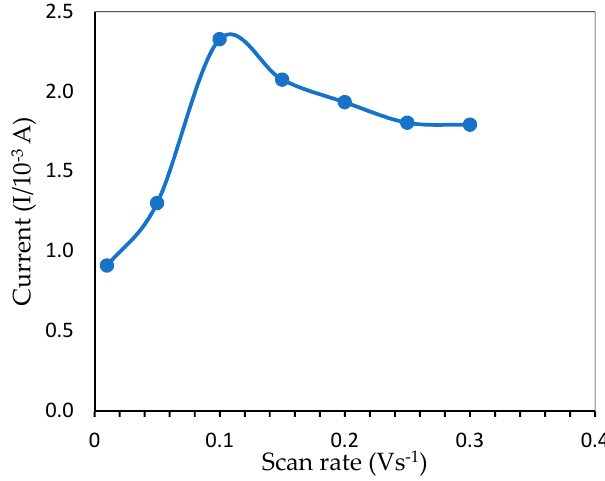
Figure 8. Peak current from CV measurement showing the effect of different scan rates for the determination of 6 ppm mercury (pH 7.0, 50 mM Tris-HCl buffer).